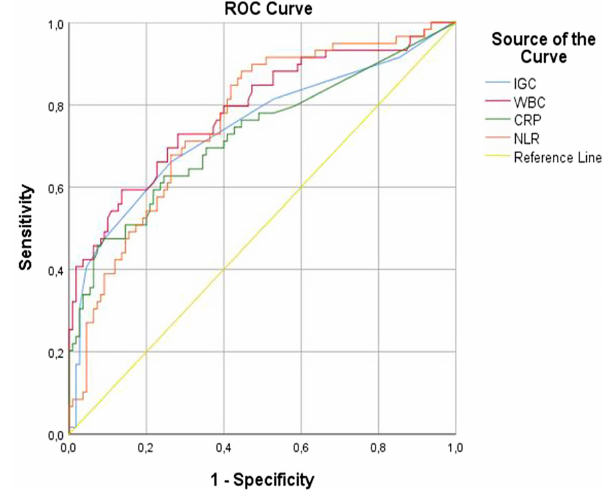
Figure 2. Receiver operating characteristic (ROC) curve analyses of IGC, WBC, CRP, NLR, IGC, and IGP to predict acute appendicitis on tomography. (IGC, immature granulocyte count; WBC, white blood cell; CRP, C-reactive protein; NLR, neutrophil to lymphocyte